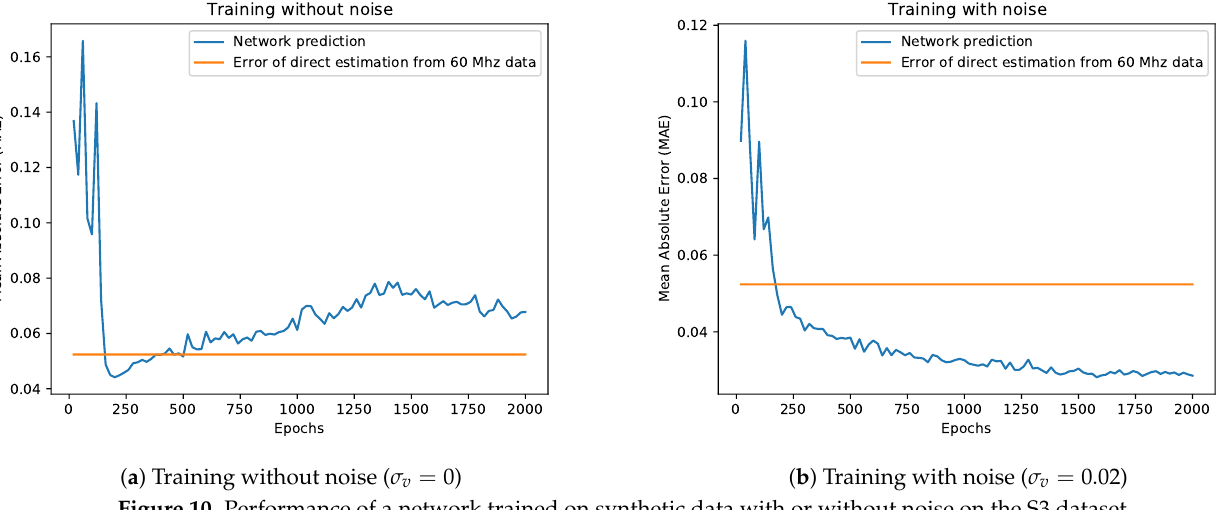
Figure 10. Performance of a network trained on synthetic data with or without noise on the S3